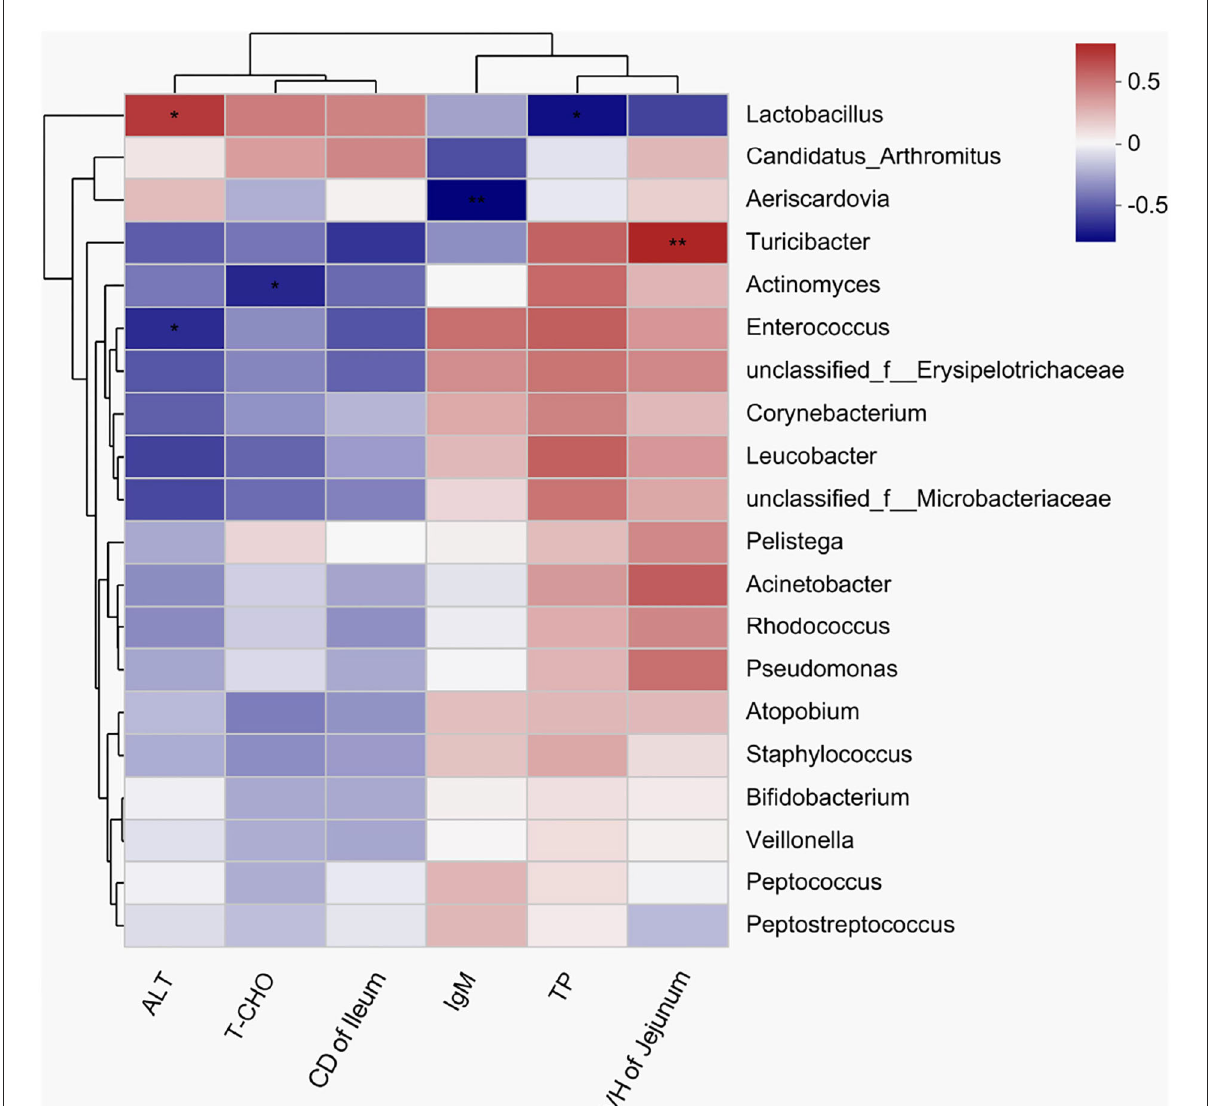
FIGURE6 A heatmap showing correlations among the bacterial genera, serum biochemical indexes, and intestinal morphology. X and Y axes are environmental factors and genera, respectively. Red indicates a positive correlation; blue indicates a negative correlation. P < 0.05 is marked with “*”, and P < 0.001 is marked with “**”. ALT, alanine aminotransferase; T-CHO, total cholesterol; IgM, immunoglobulin M; TP, total